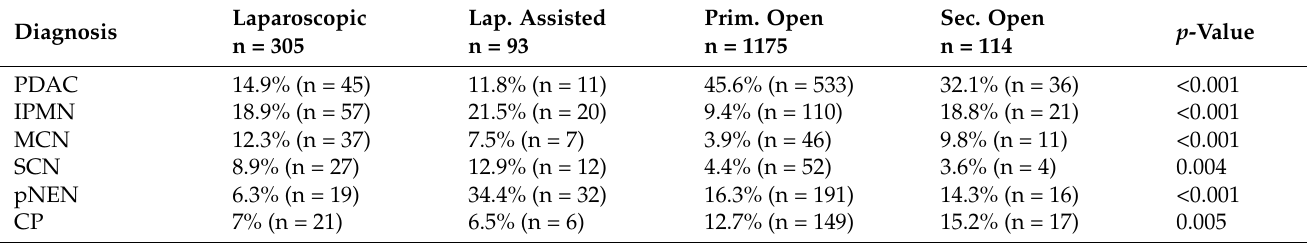
Table 3. Histological diagnosis apportioned by the surgical technique; PDAC, pancreatic ductal adenocarcinoma; IPMN, intrapapillary mucinous neoplasms; MCN, mucinous cystic neoplasms; SCN, serous cystic neoplasms; pNEN, pancreatic neuroendocrine neoplasms; CP, chronic